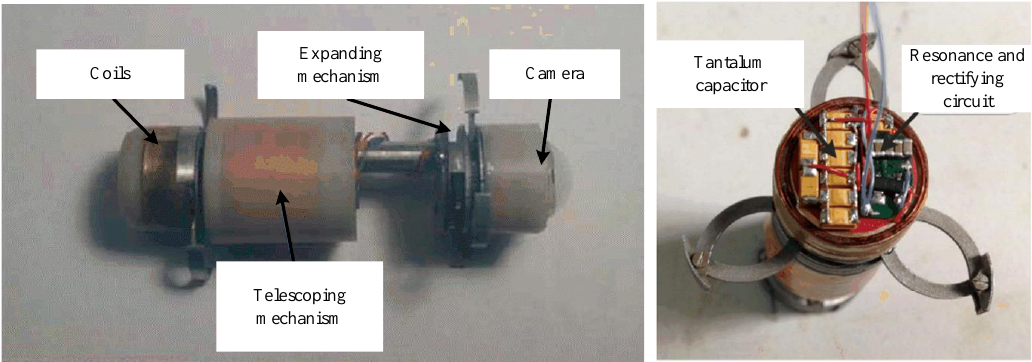
Figure 11. Prototype of the microrobot with proposed receiving coils.